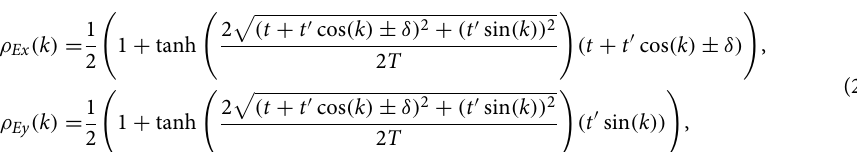
and corresponding Gibb’s states are given by